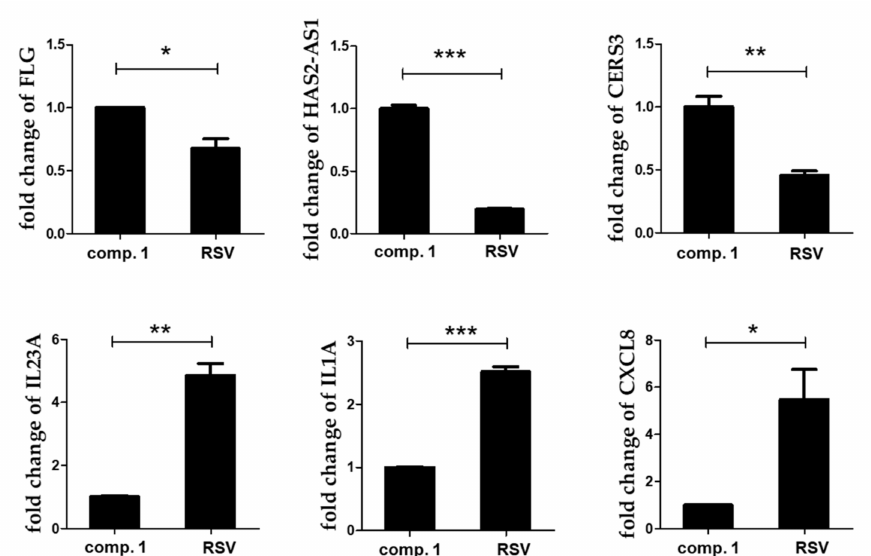
Figure 3. The key differentially expressed mRNAs identified from microarray were verified using qRT-PCR. The expression of genes in resvebassianol A ( 1 )- and RSV-treated groups was consistent with the results of gene chip detection. Values are expressed as means ± SD. * p < 0.05, ** p < 0.01, and *** p < 0.001 vs. RSV-treated group; Comp. means